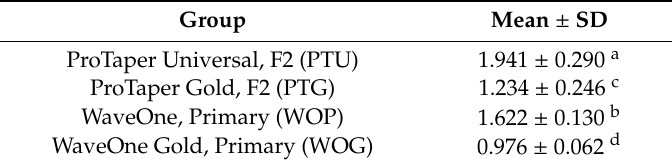
Table 1. Maximum screw-in forces (N) during instrumentation procedures.